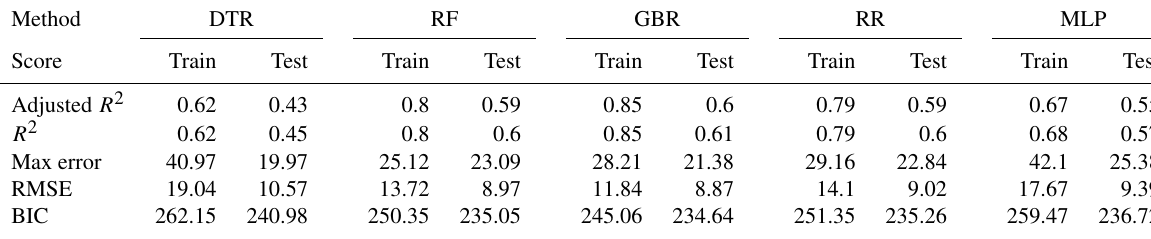
Table A3. Training and test scores on annual basis for the rural population. Method